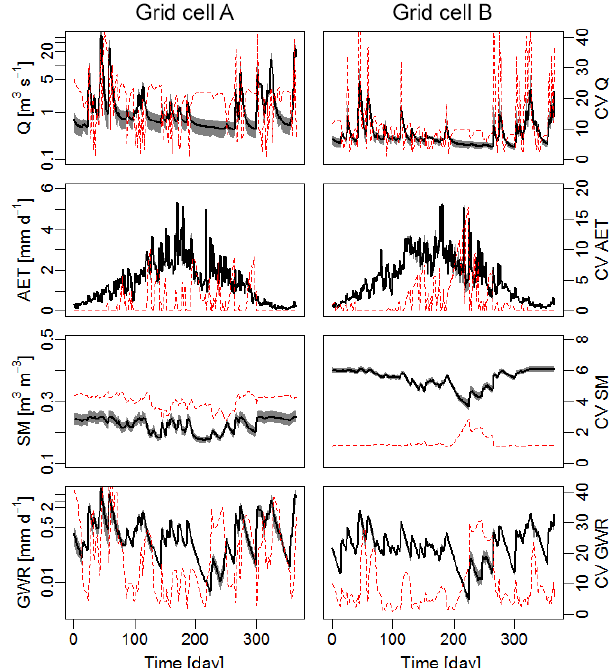
Figure 8. Daily temporal variability of the uncertainty in states and fluxes ( Q is runoff, AET is evapotranspiration, SM is soil moisture, GWR is groundwater recharge) obtained in two grid cells within the catchment obtained based on the random error (RE) method. The mean (black) and the 95% confidence interval (grey) of the ensemble is depicted together with the coefficient of variation (CV) calculated at daily time step (red). Note the log y axis for Q and GWR. Location of grid cell A and B is shown in Figs. 2 and